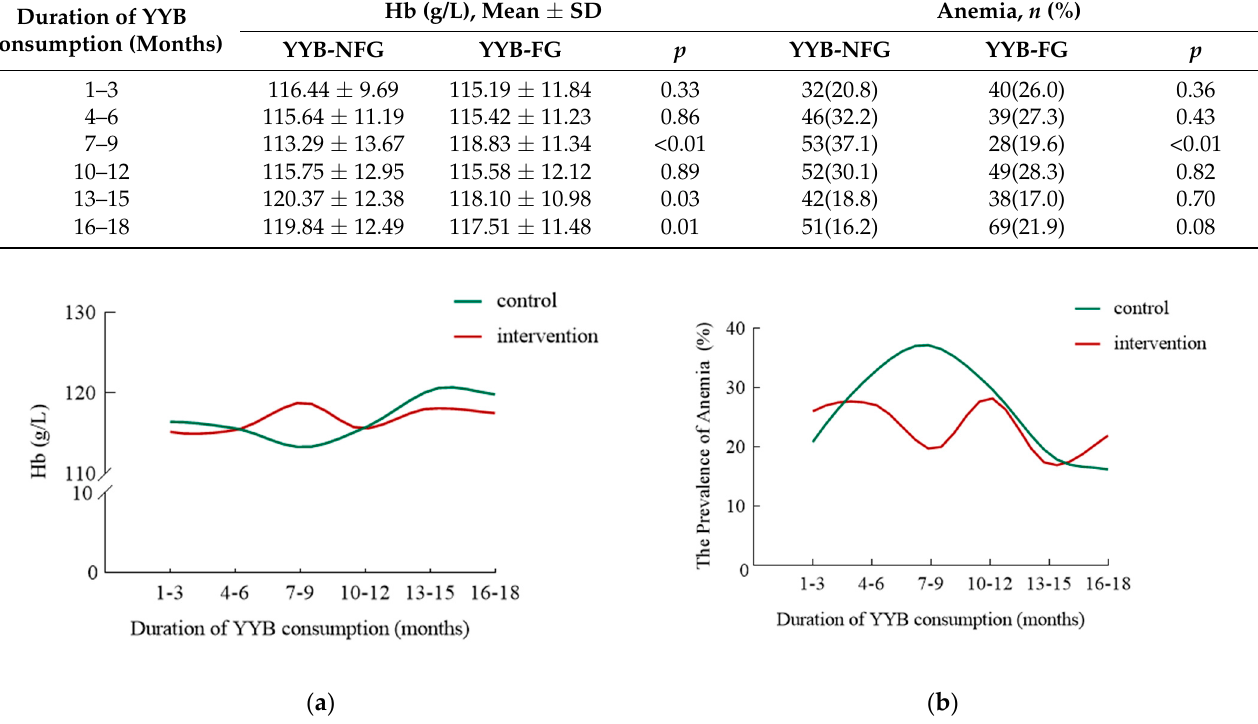
Figure 3. Hb level and the prevalence of anemia of IYC with different duration of YYB consumption. ( a ) The line chart shows the Hb of IYC in the control group (green) and the intervention group (red) at different stages. ( b ) The line chart shows the prevalence of anemia in the control group (green) and intervention group (red) at different stages. Hb: hemoglobin levels; YYB: Ying Yang Bao; YYB-FG: Ying Yang Bao feeding group; YYB-NFG: Ying Yang Bao non-feeding group.